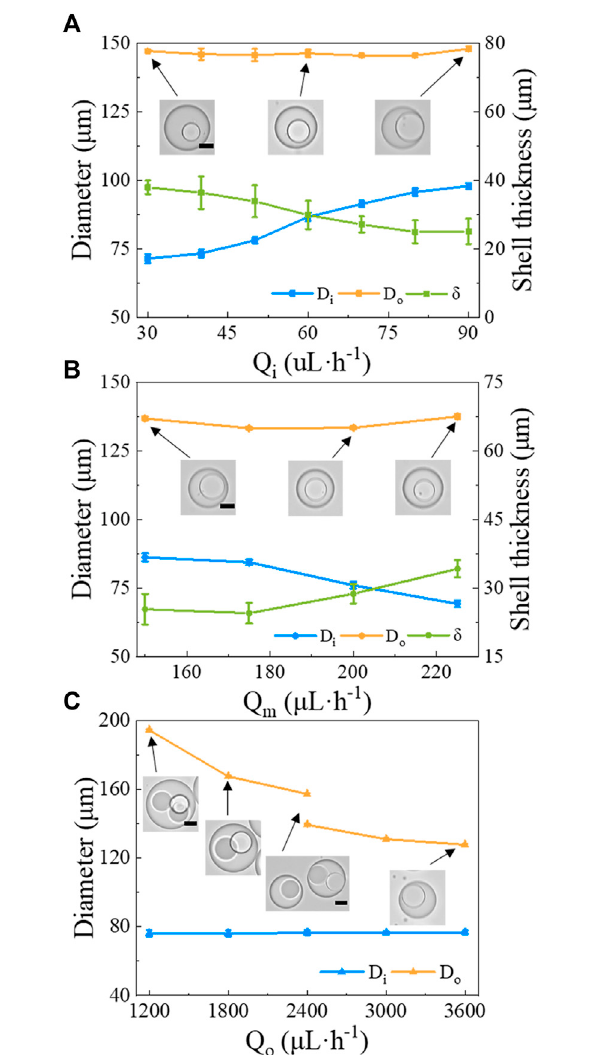
FIGURE 5 | The morphology of w/PDMS/w DE droplets versus fl ow rates of the different phases. The diameter of the core (D i ), the diameter of the DE droplet (D o ), and the shell thickness δ are shown under the following conditions: (A) varying Q i , while keeping Q m = 200 μ L/h and Q o = 3,000 μ L/h; (B) varying Q m , while Q i = 50 μ L/h and Q o = 3,000 μ L/h; (C) varying Q